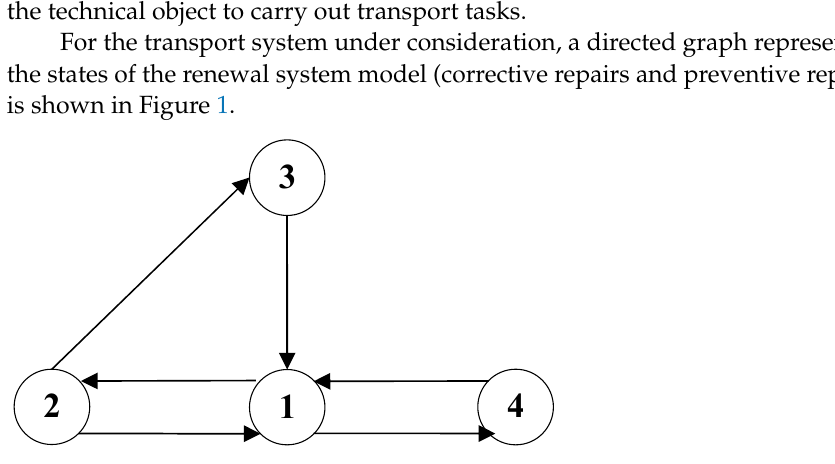
Figure 1. Directed graph mapping the changes in states of the renewal system model S = {1, 2, 3, 4}.